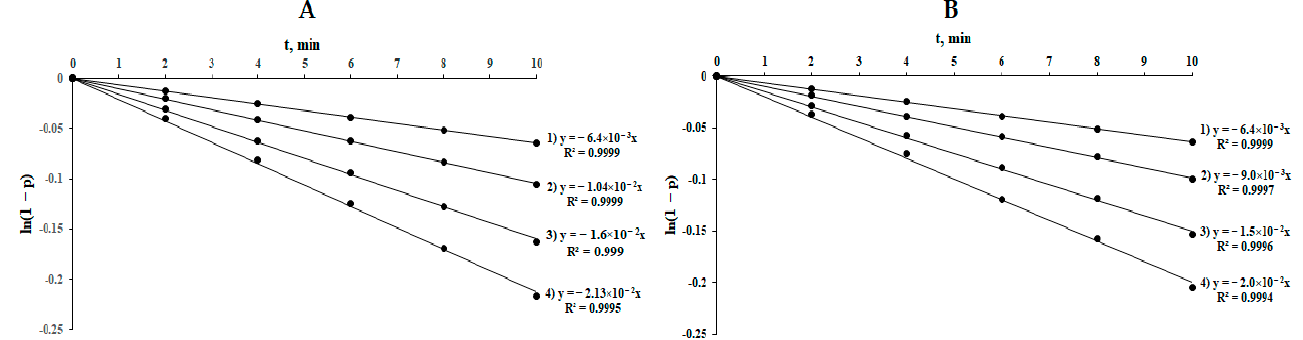
Figure 2. Linear dependences in coordinates ln (1-p) vs. t in the presence of sulfanylethanoic acid ( A ) and 3-sulfanylpropanoic acid ( B ) at different initial concentrations of chain transfer agents: 1—without a chain transfer agent; 2—0.09; 3—0.47; 4—1.4 mol × l − 1 (initial concentration of AIBN 6.30 × 10 − 2 mol × l − 1 , temperature 343 K).